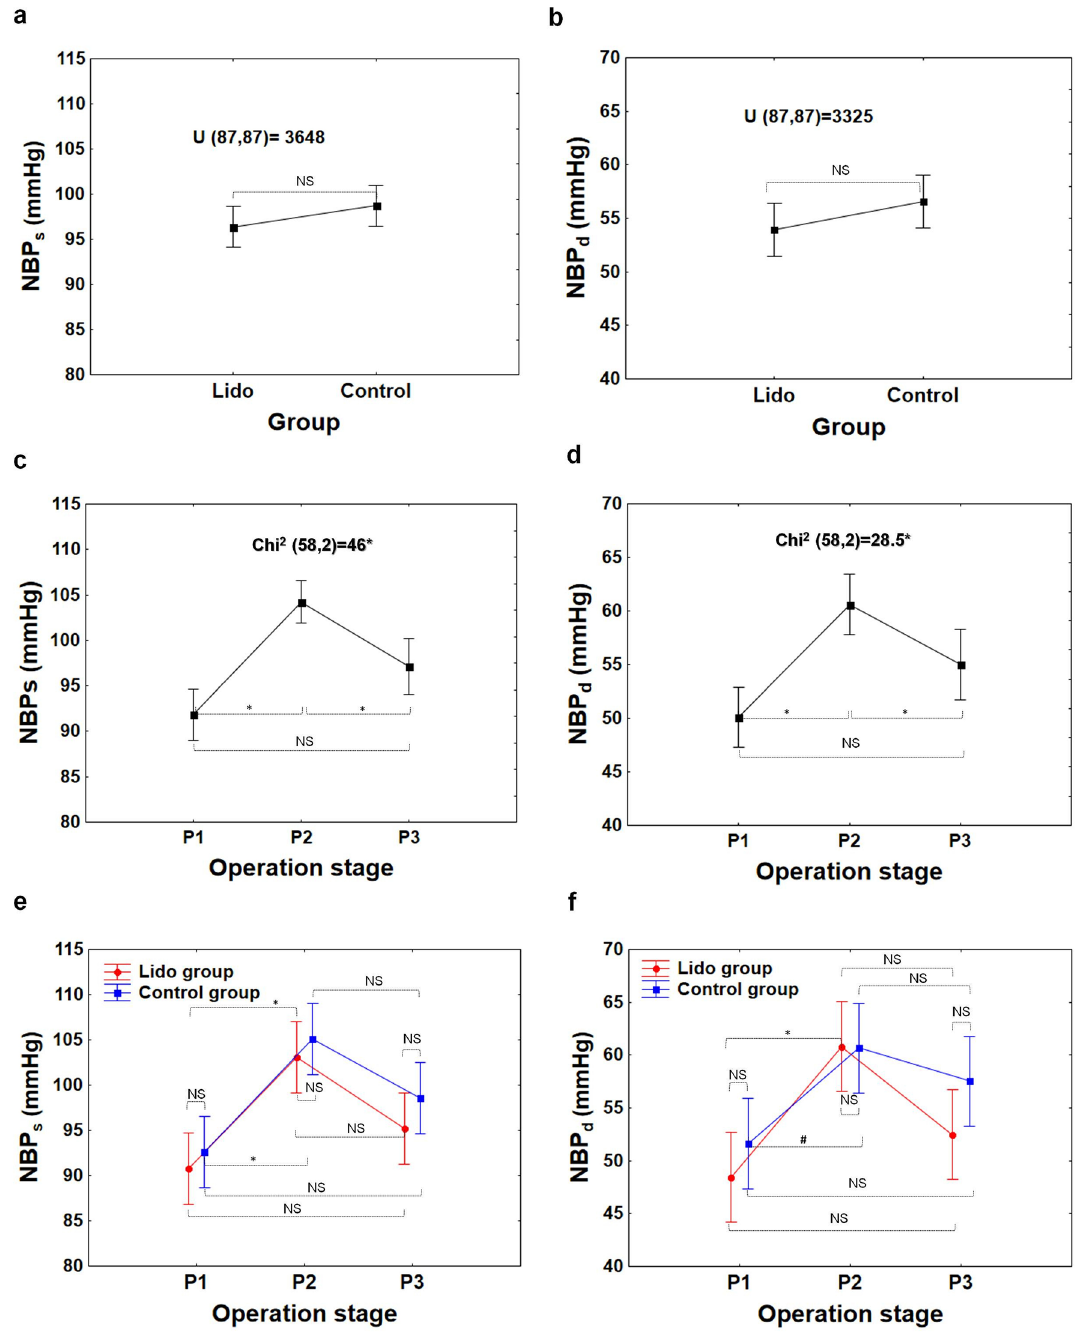
Figure 5. Systolic and diastolic blood pressure (NBP s , NBP d ) at the beginning (P 1 −baseline), during (P 2 ), and at the end of surgery (P 3 ) in the Lido and Control group. The differences between patients’ groups are insignificant (NS), ( a , b ). The differences between the P 1 , P 2 and P 3 stages are significant ( c , d ); *P < 0.001 (1 − β = 0.99 and 1 − β = 0.98 for c and d respectively, at α = 0.001). The difference between Lido and Control group at the P 1 , P 2 and P 3 level is insignificant (NS), ( e , f ). # P <